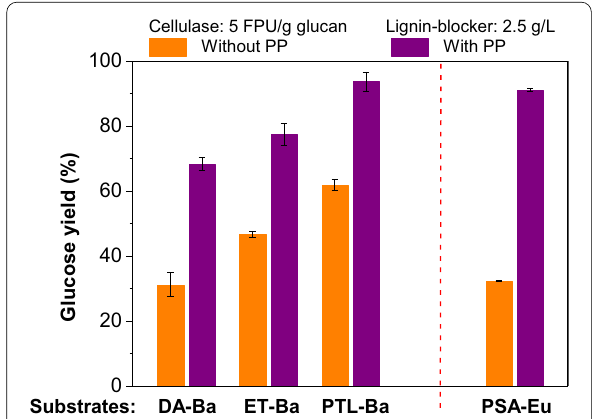
Fig. 4 Application of PP to the bamboo and eucalyptus substrates pretreated by different methods. The pH value of buffer solutions and β-glucosidase loading for all enzymatic hydrolysis were 5 and 10 CBU/g glucan,